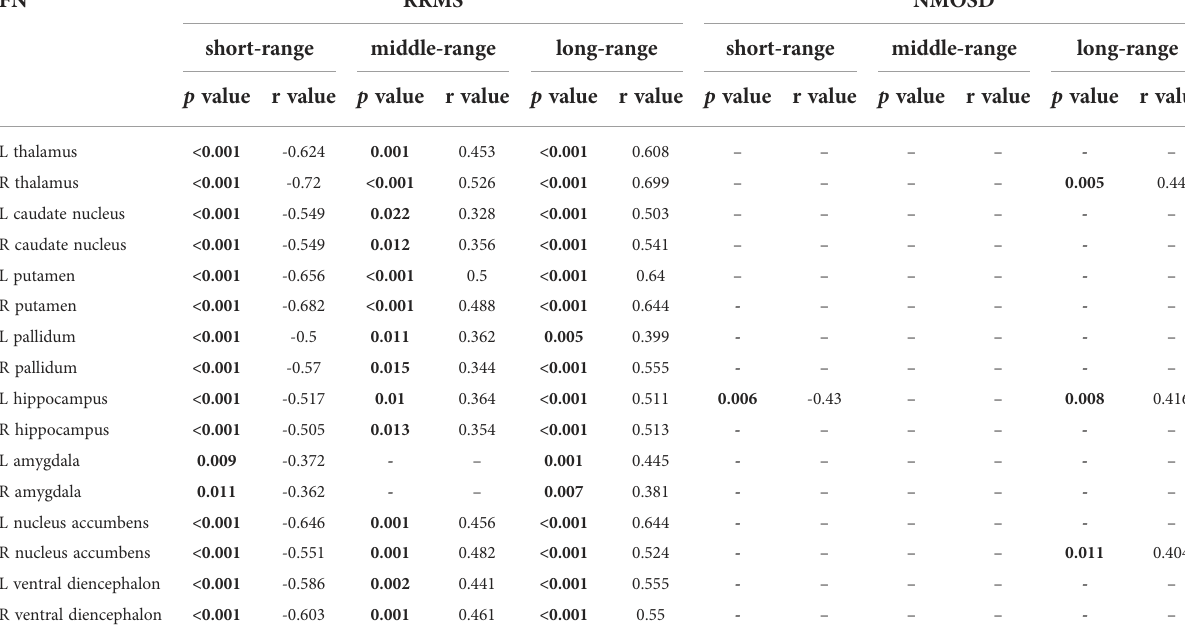
TABLE 4 The correlation between FN of different fi bers connections lengths and the deep grey matter volume in RRMS and NMOSD. FN RRMS NMOSD short-range middle-range long-range short-range middle-range